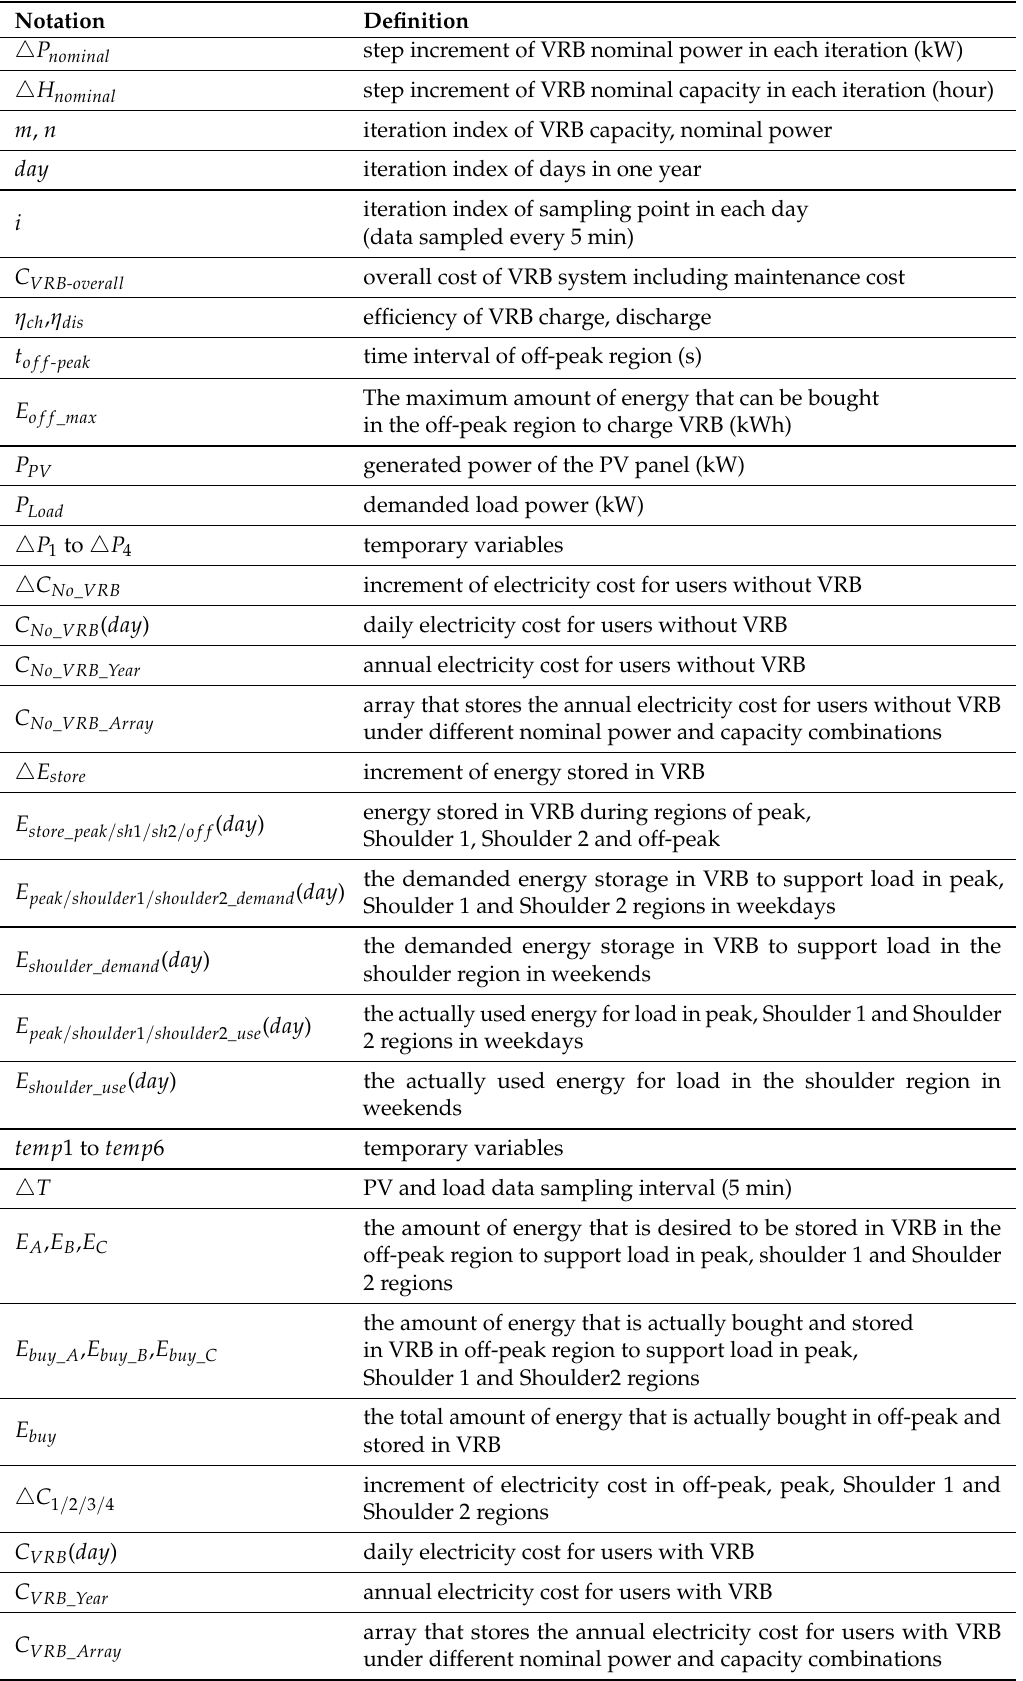
Table 3. Definition of notations in the flow chart of Figure